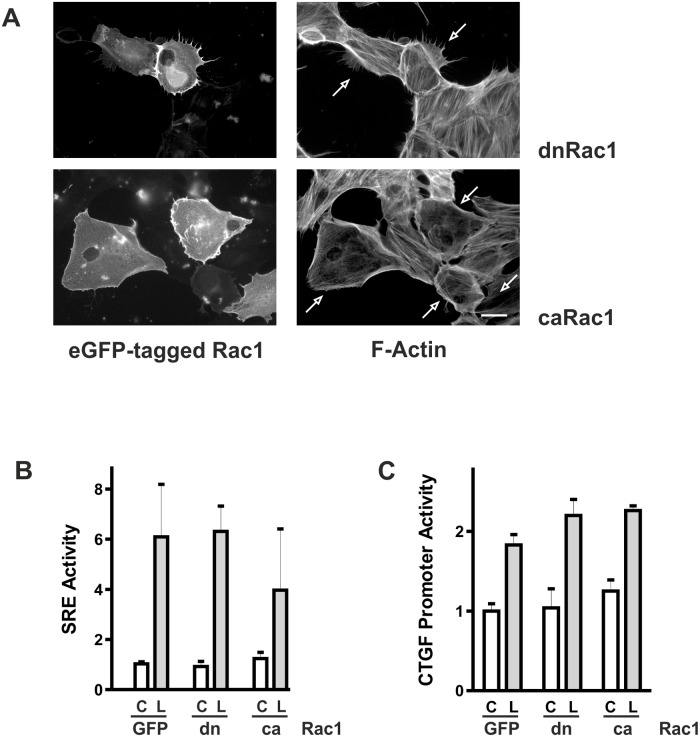
Overexpression of activated or dominant negative Rac1 alters cell morphology but not CTGF expression.(A) HKC-8 cells were transfected with dominant negative Rac1 (T17N) or constitutively active Rac1 (G12V) coupled to eGFP. 24 h after transfection, cells were stimulated with LPA (10 μM) for 1 h. F-actin fibers were visualized with PromoFluor phalloidin. Arrows indicate transfected cells. Scale bar: 20 μm. (B) HKC-8 cells were transfected with eGFP-coupled dominant negative (dn) or constitutively active (ca) Rac1, or eGFP (GFP) as control together with luciferase-coupled SRE constructs. Expression of cotransfected beta galactosidase was used as reference. Cells were stimulated with LPA (L, 10 μM) for 4 h. Data shown are means ± SD of 3–5 independent experiments performed with duplicate transfections. In each experiment the mean of the unstimulated control values was set to 1. (C) Cells were treated as in (B) but transfected with a 4.5 kb CTGF promoter construct. Data are means of 3 independent experiments with duplicate transfections. In each experiment the mean of the unstimulated control values was set to 1.